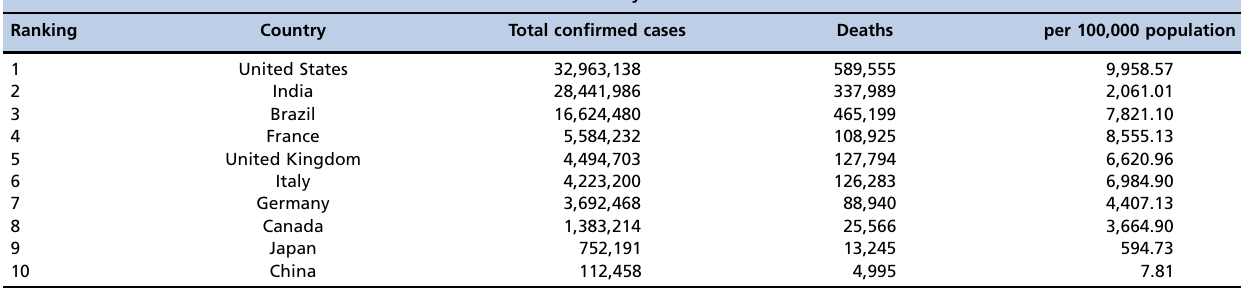
Table 1 - Ranking of Countries by Total Positive Cases and Lethality.